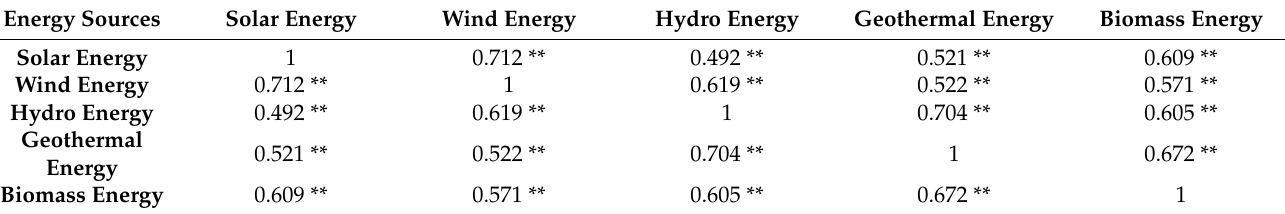
Table 9. Correlation of renewable energy sources.